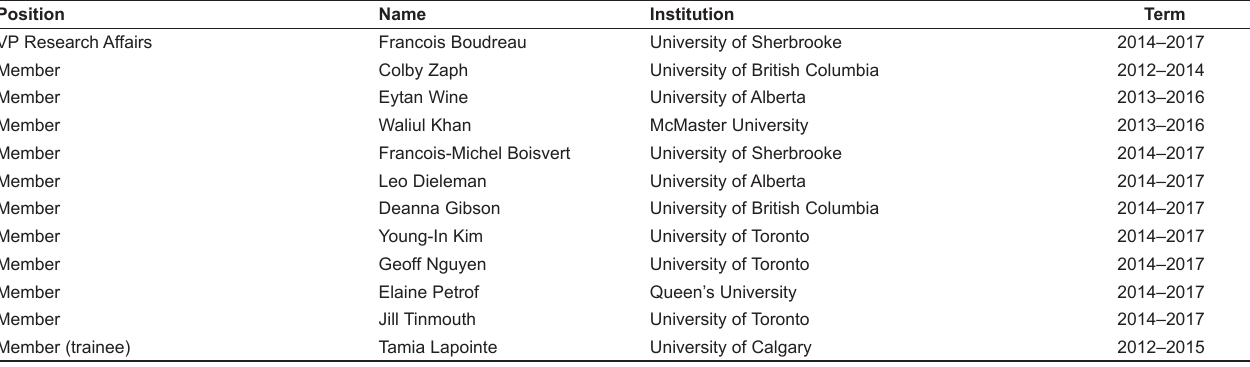
TAble 1 Members of the Canadian Association of Gastroenterology Research Committee 2014